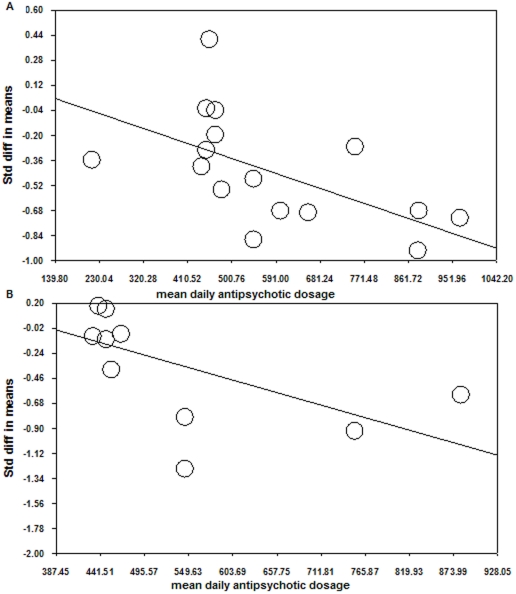
Regression of mean daily antipsychotic dosage on effect sizes of A: N400 effect (upper panel) and B: N400 amplitudes for congruent/related conditions (lower panel).